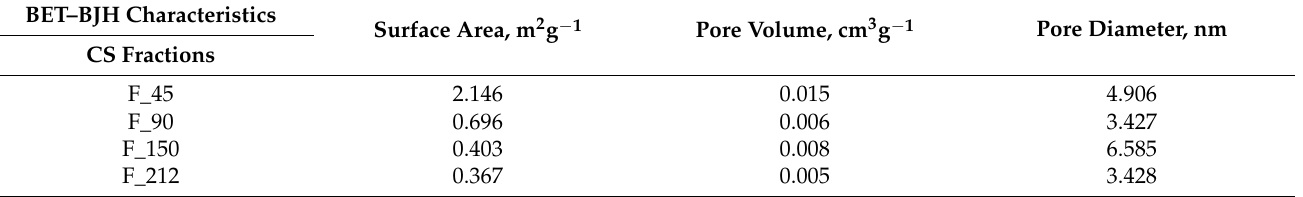
Table 6. Real density measurement CS data.